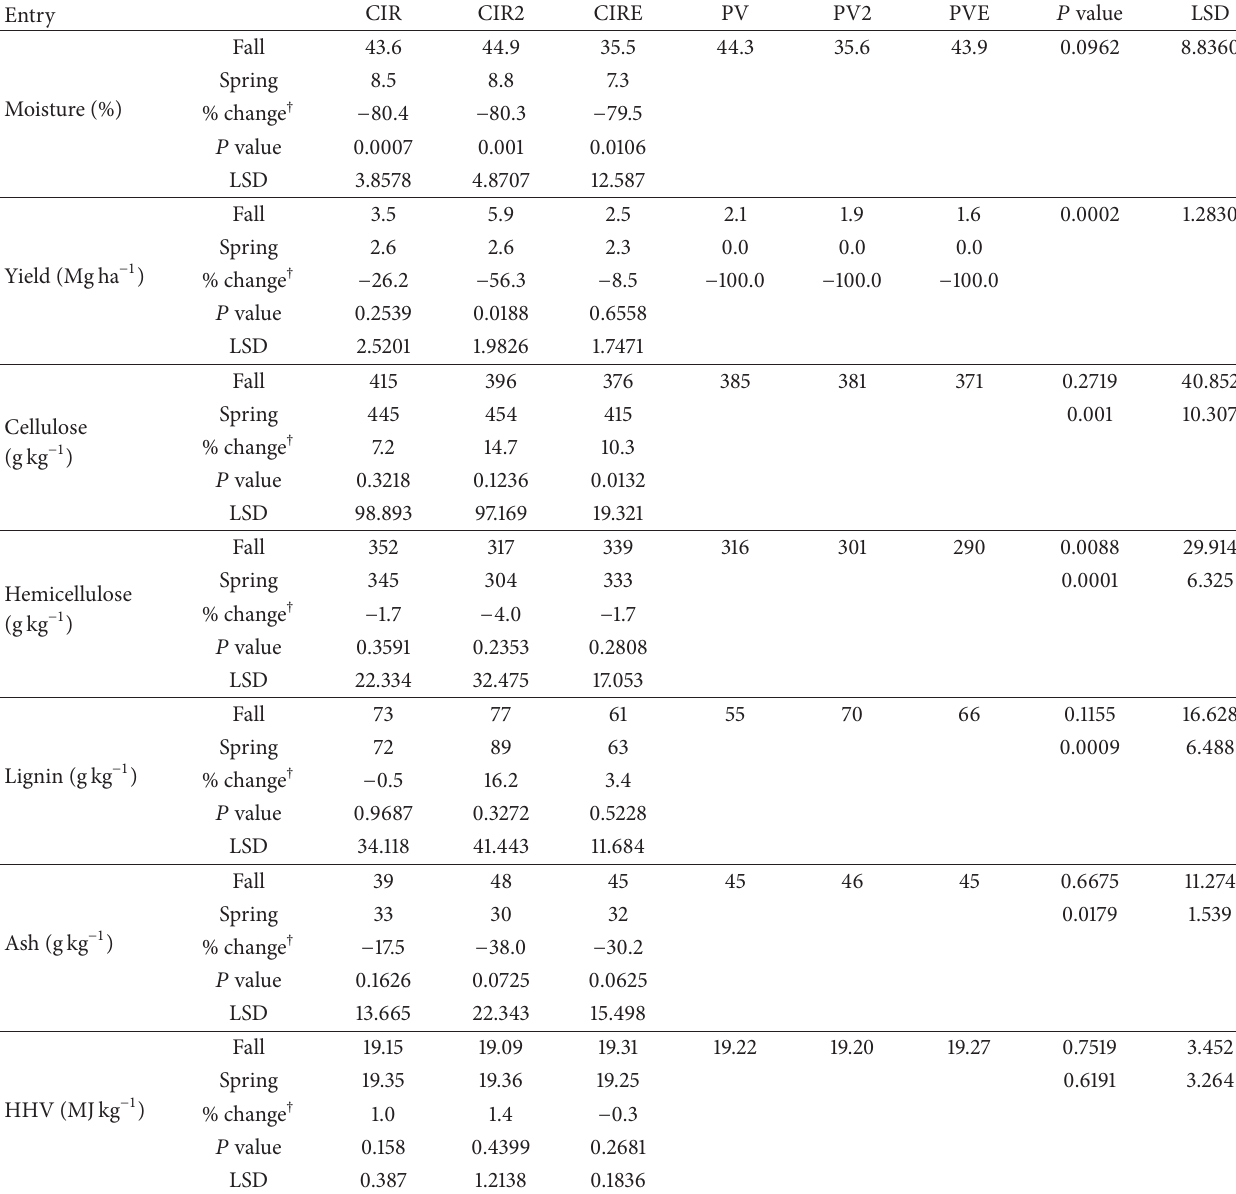
Table 5: Fall of 2011 and spring of 2012 values on dry matter basis for yield, moisture concentration, cell wall components, ash, and higher heating value (HHV) of three selections of switchgrass and three selections of big bluestem in Cookshire-Eaton,